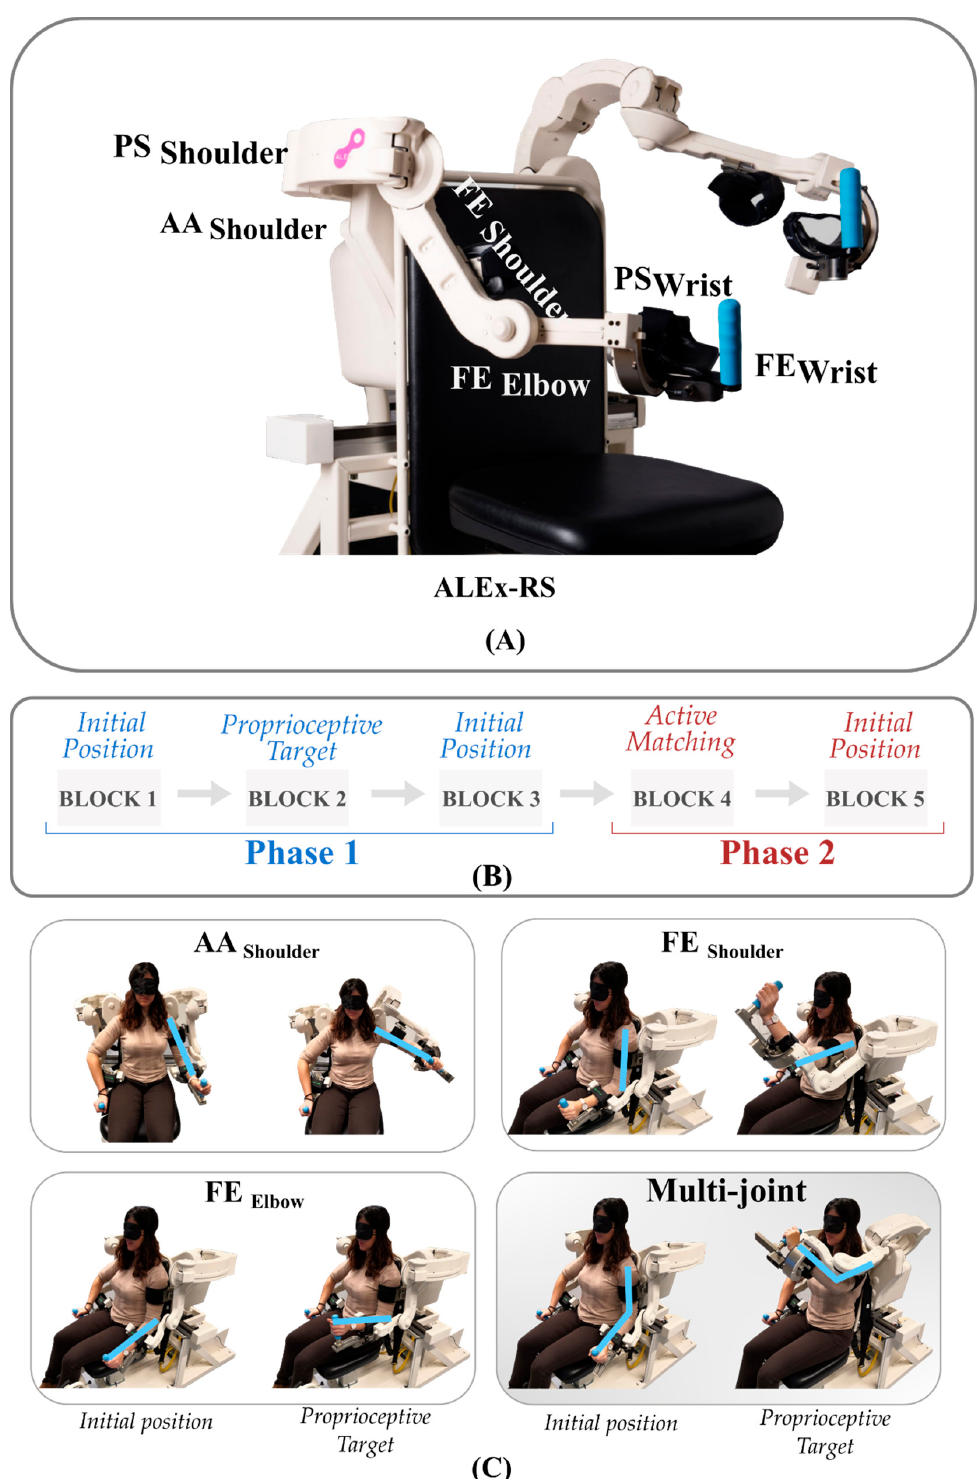
Figure 1. ( A ) Bimanual ALEx-RS device. ( B ) Block sequence presented to the participants during the ipsilateral joint position matching (JPM) task. ( C ) Task representation: participants sat on the workstation chair wearing one of the robotic exoskeletons, according to the tested body side. They were requested to grasp a pressure-sensitive handle of the contralateral exoskeleton (non-tested side). On the top left is illustrated the single joint (SJ) condition for the AA Shoulder , on the top right for the FE Shoulder , on the bottom left for the FE Elbow . On the bottom right is illustrated the multi-joint (MJ) condition. For all conditions is shown the Initial Position on the left and the Proprioceptive Target position on the right.